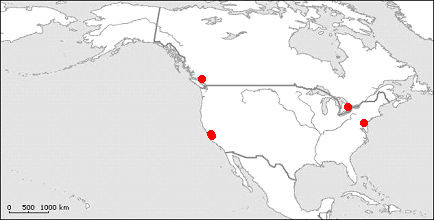
Participating centers from the United States of America and Canada in the Delphi trial.